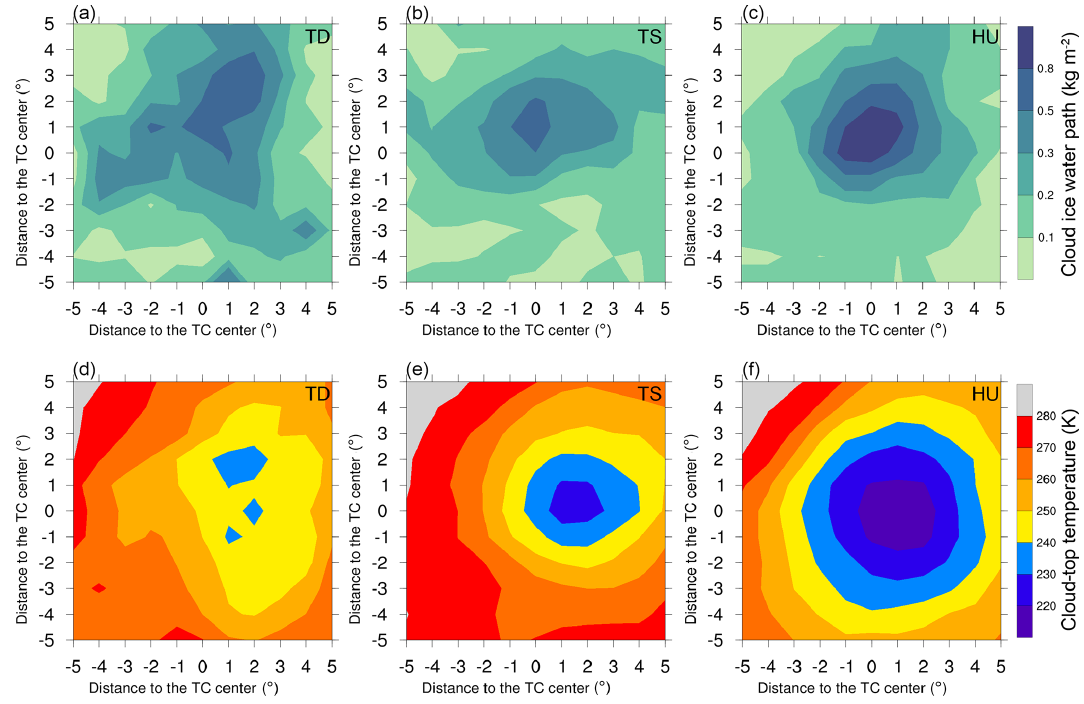
Figure 5. The spatial distributions of (a–c) CIWP and (d–e) CTT of the composite TD, TS, and HU, respectively.